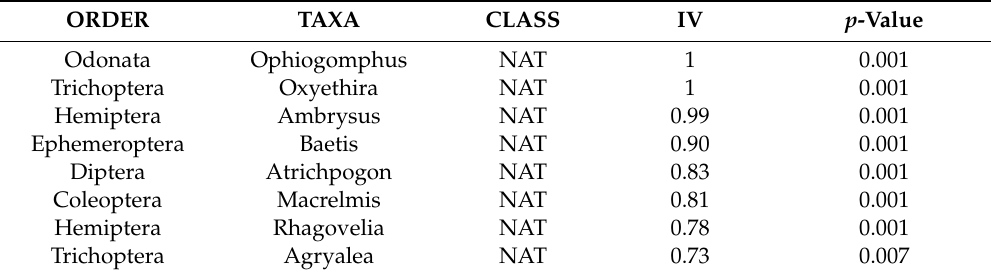
Table 2. Results of the indicator species analysis (IndVal), maximum IV significance (IV is the individual value), associated to land use class for each species (NAT for Natural, URB for Urban, and AGR for agricultural land use).